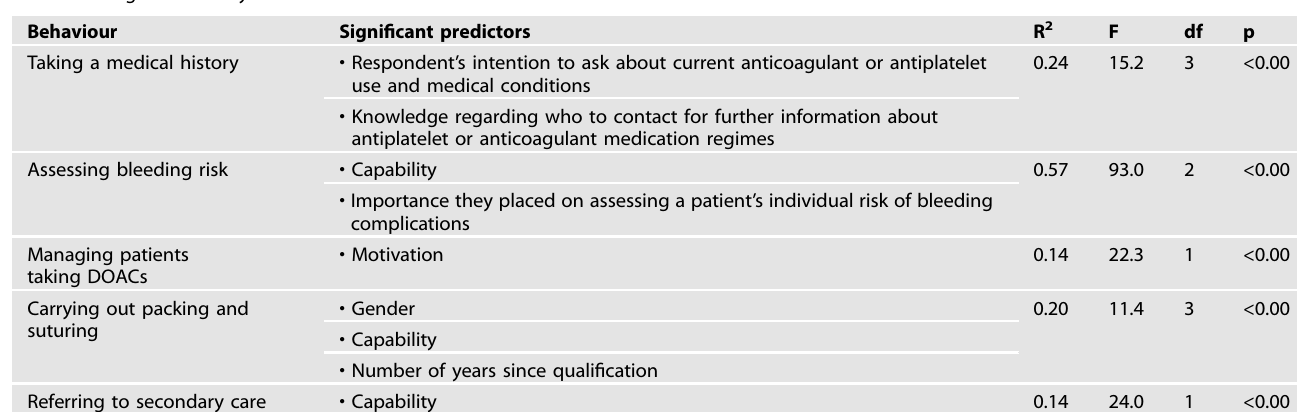
Table 3. Regression analysis. Behaviour